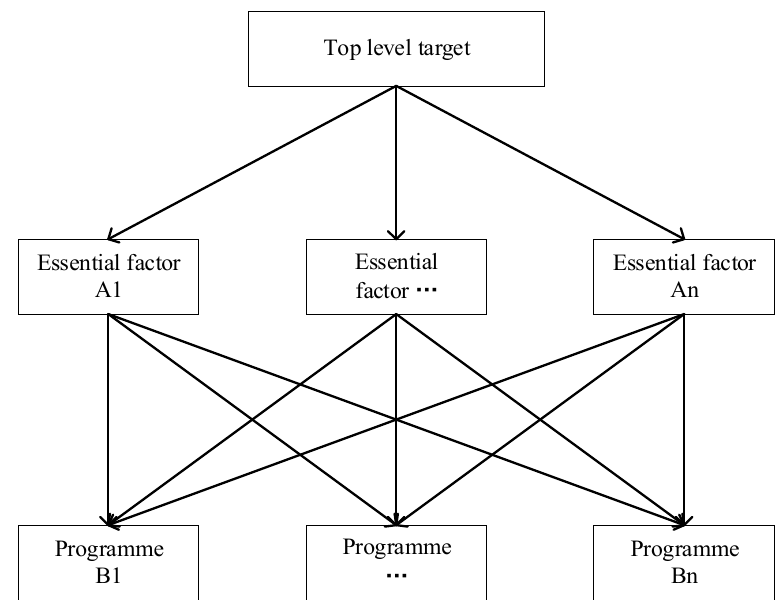
Figure 1. Basic model of analytic hierarchy process.